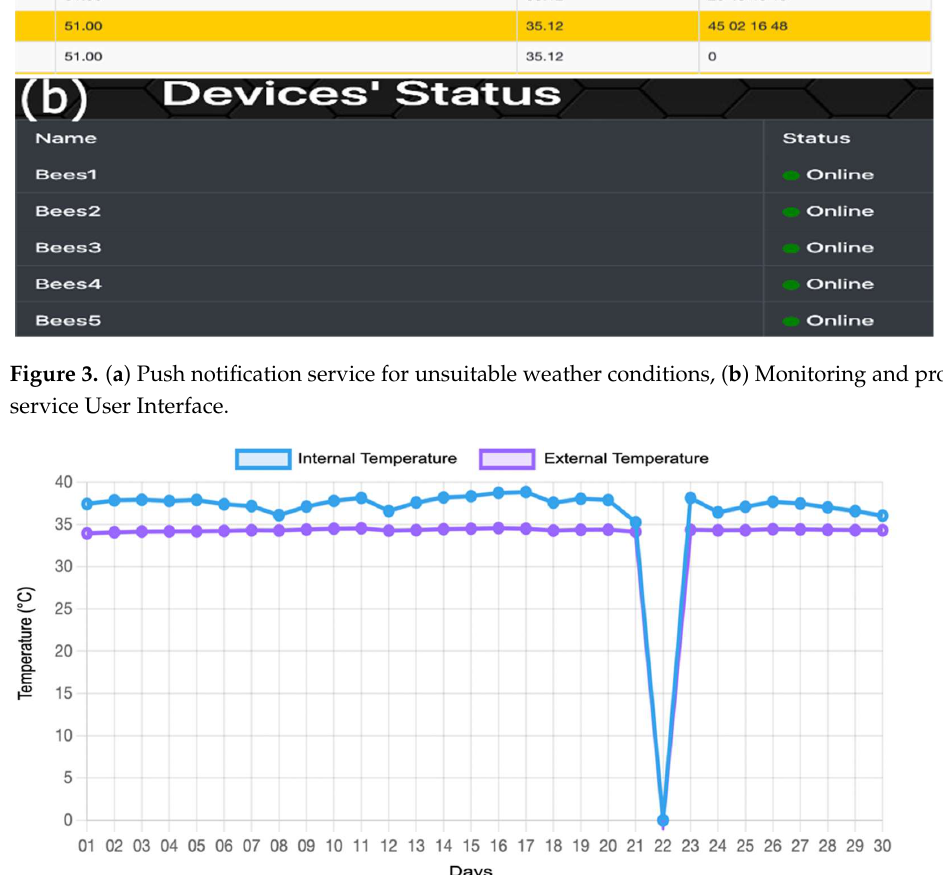
Figure 3. ( a ) Push notification service for unsuitable weather conditions, ( b ) Monitoring and probing service User Interface.